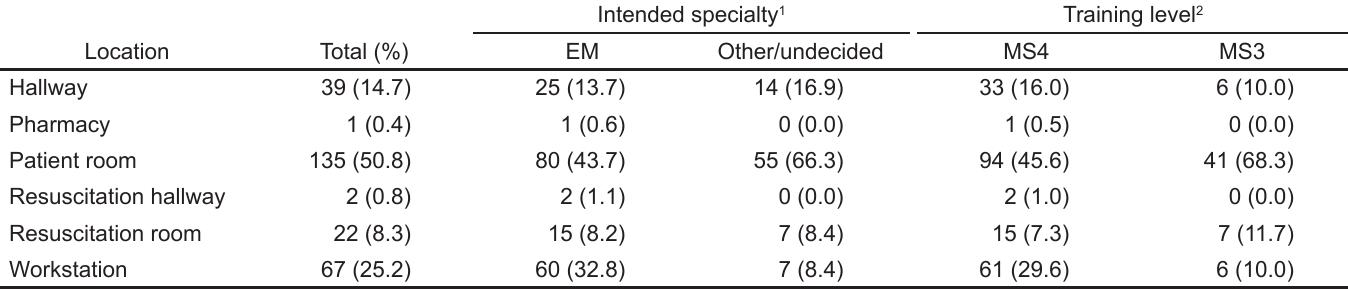
Table 2. Location of “learning moments” by intended specialty and training level